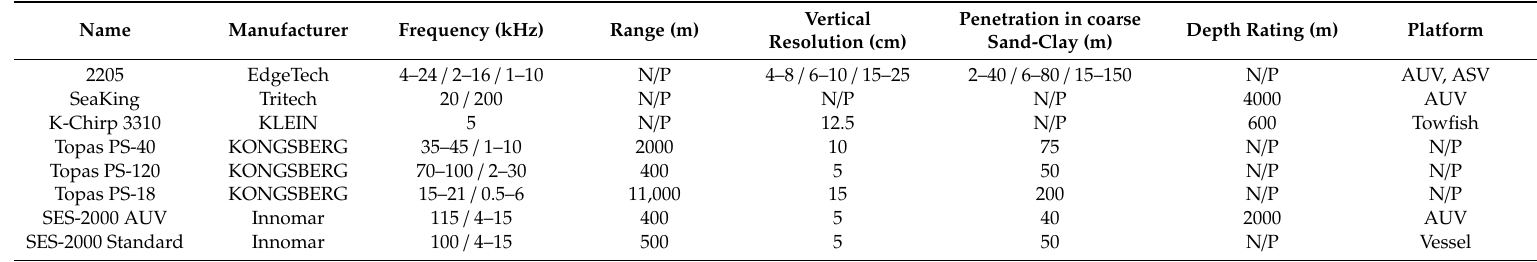
Table 9. Acoustic sensor: sub-bottom profiler